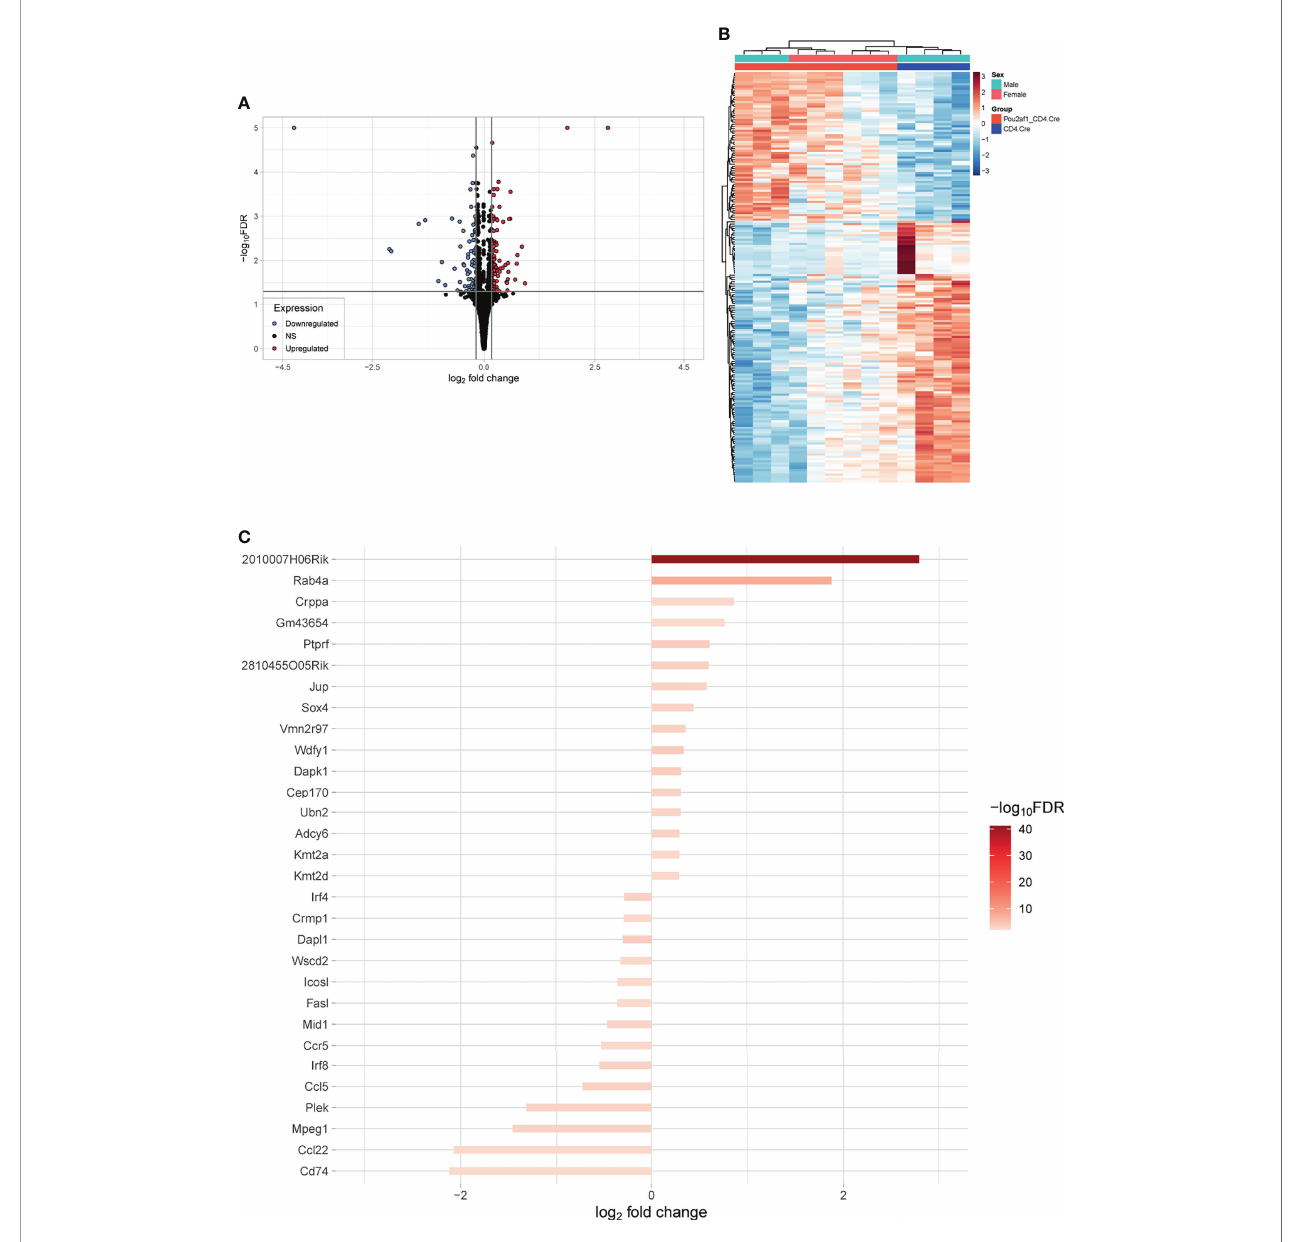
FIGURE 6 | Differential gene expression between CD4 + T cells of Pou2af1 fl / fl x CD4-Cre and CD4-Cre control mice. CD4 + T cells from immunized Pou2af1 fl / fl x CD4- Cre and CD4-Cre controls were isolated from LNs and RNA-seq analysis was performed. (A) Volcano plot showing 158 DEGs at FDR 0.05 including 61 upregulated and 97 downregulated genes. The horizontal grey line indicates FDR cutoff of 0.05 and the vertical lines indicate the applied 99 th percentile cutoff of the log2foldchange. (B) Heatmap showing DEGs at FDR 0.01. (C) Waterfall plot showing the top 30 DEGs at FDR 0.01. Expression of Pou2af1 was excluded from the top 30